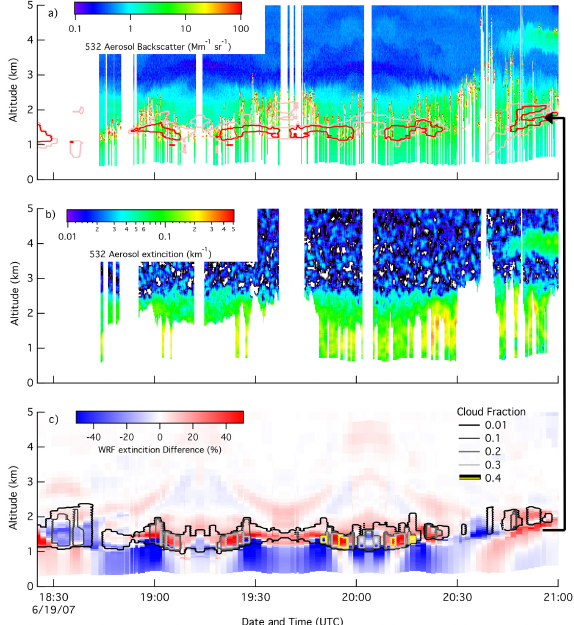
Figure 7. Cross sections of observed aerosol backscatter (a) , aerosol extinction (b) at a wavelength of 532nm, and the difference in aerosol extinction of DeepShallow and Control simulations (c) on 19 June 2007. Contours in (a) mark contours of + 10 and + 20% difference in the WRF-Chem simulations, as indicated by the large arrow, and contours in (c) indicate simulated cloud fraction as indi- cated by the legend.